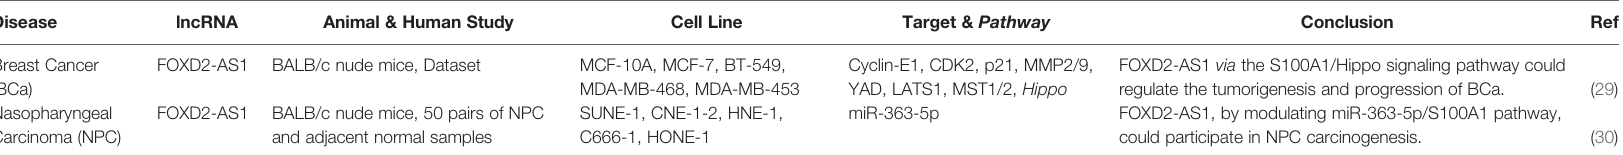
TABLE 6 | S100A1-interacting